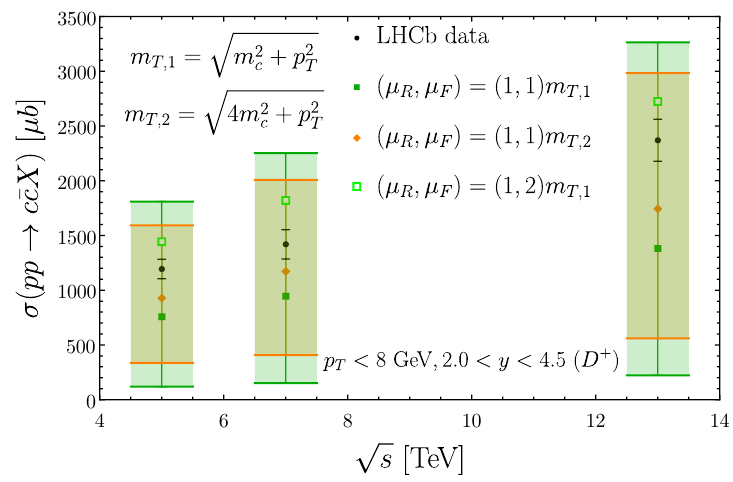
Figure 3. NLO QCD predictions for the equivalent charm-quark pair production fiducial cross sections σ ( pp → c ¯ cX ) from charm meson ( D + ) production in a fiducial region with p T < 8 GeV √ and 2 . 0 < y < 4 . 5 for s = 5 , 7 and 13 TeV, compared to the cross sections determined by the LHCb experiment [18–20] in the same fiducial region. The orange (green) error bands represent the scale dependence uncertainties for the theoretical predictions, for renormalization and factorization scales proportional to m T, 2 ( m T, 1 = m T ). The green open marker represents central predictions with ( µ R , µ F ) = (1 , 2) m T, 1